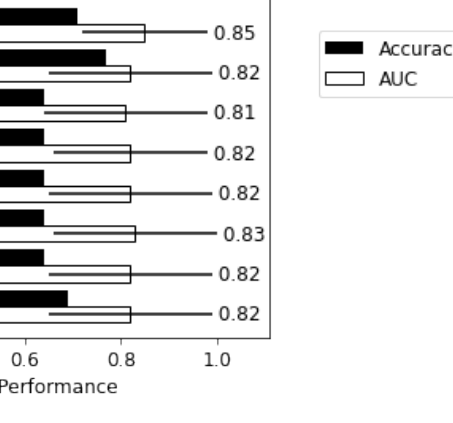
Figure 5. Diagnostic utility of individual SUV